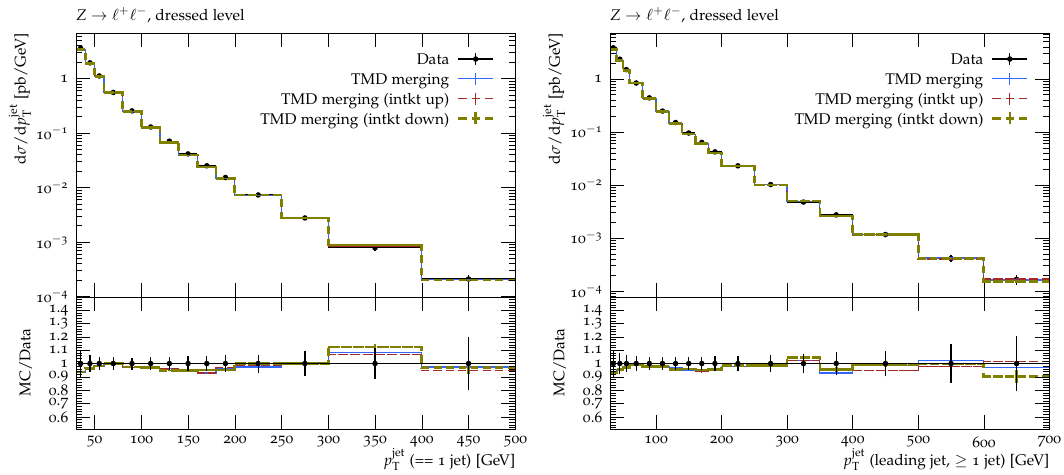
Figure 29 . Exclusive (left) and inclusive (right) leading-jet p T spectra in Z +jet events: intrinsic- k T